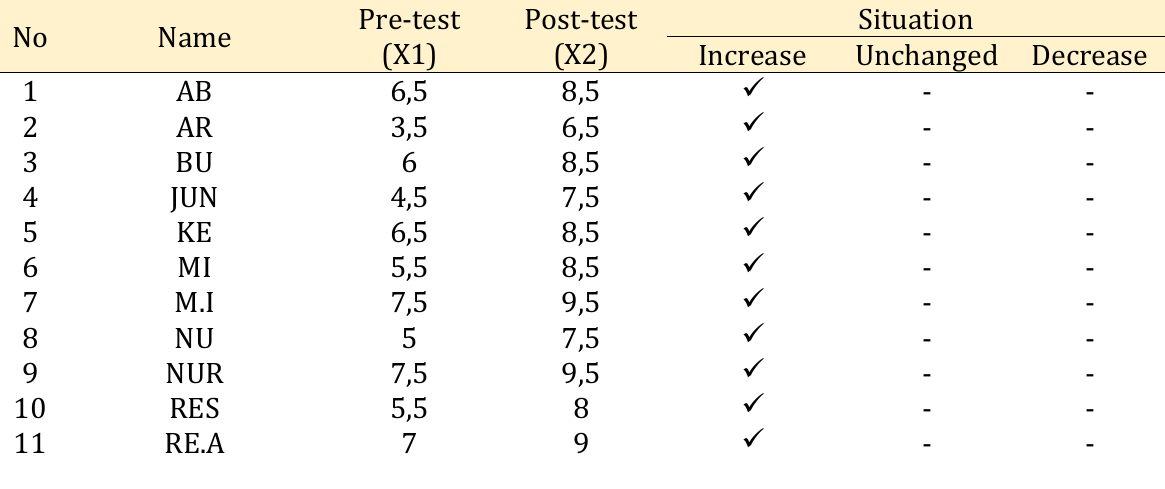
Table 8. The students ’ situation sc